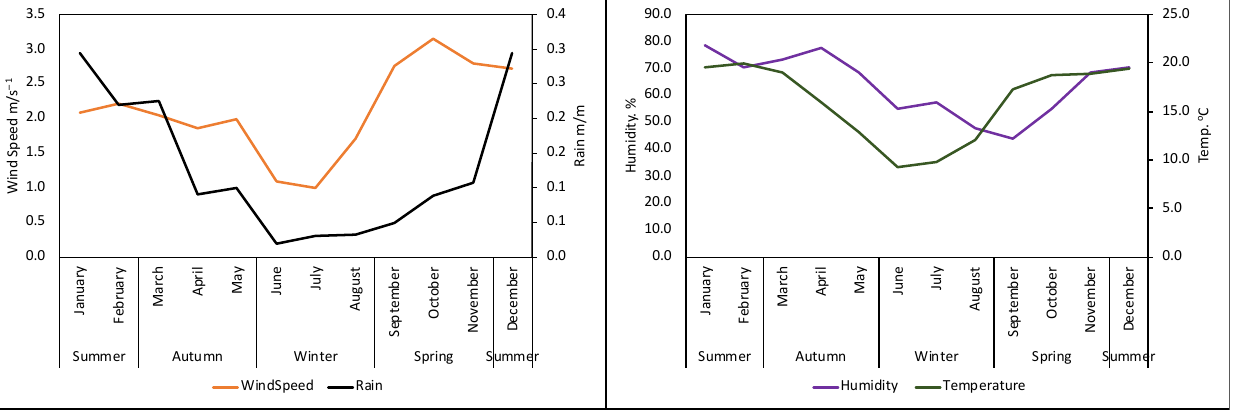
Figure 7. Seasonal ground observation meteorological weather conditions observed at Secunda.